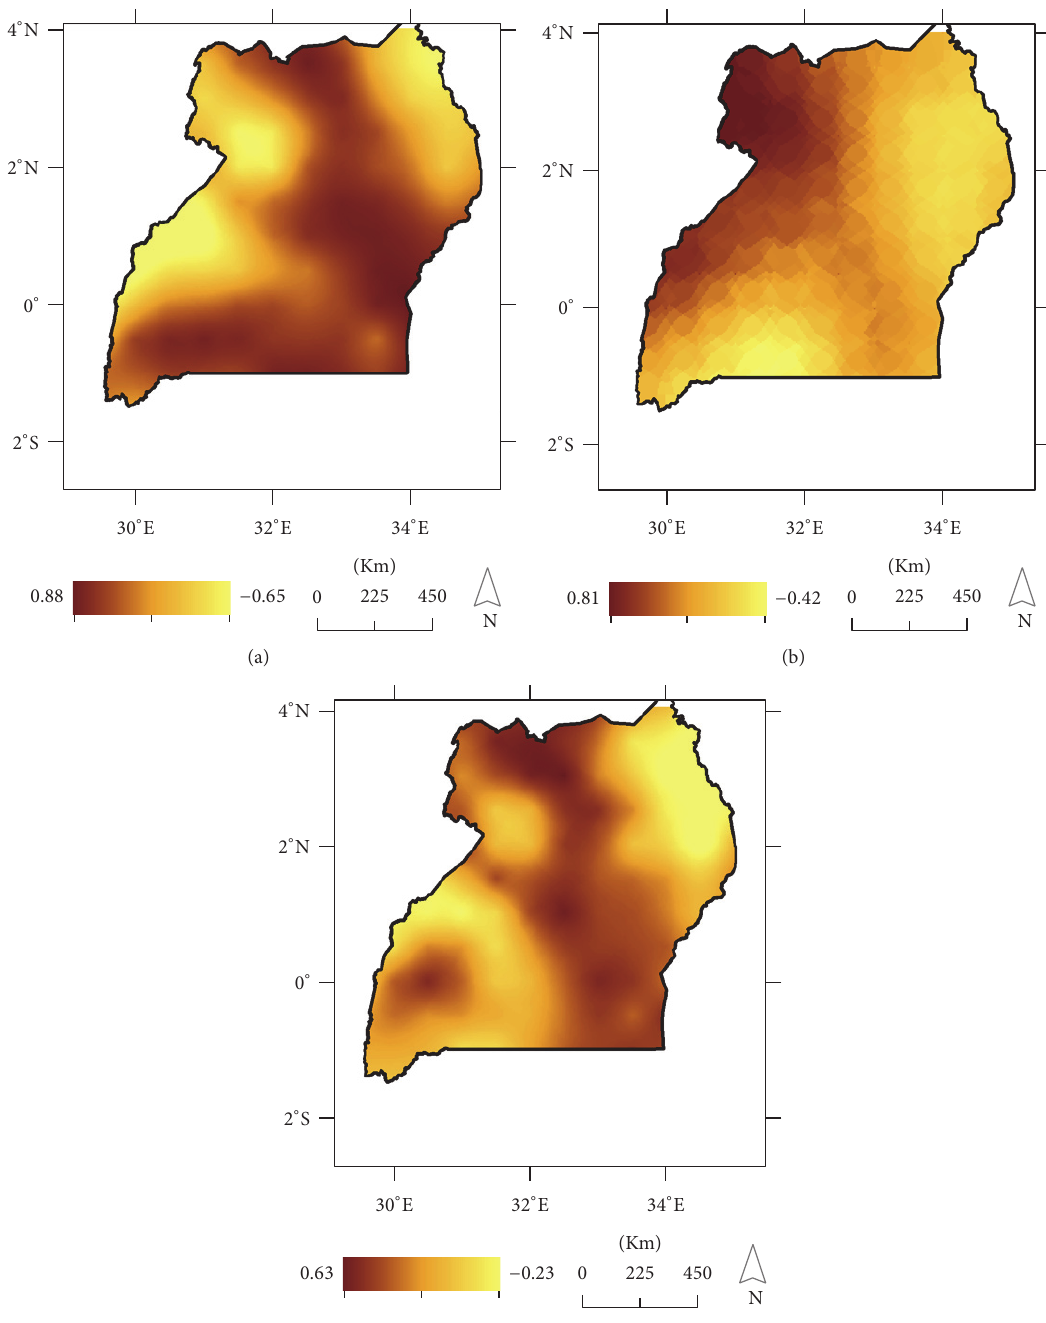
Figure 5: Spatial variation in (a) EOF1, (b) EOF2, and (c) EOF (1 ¤ 2) sets of EOF factor loadings obtained by surface interpolation (Kriging